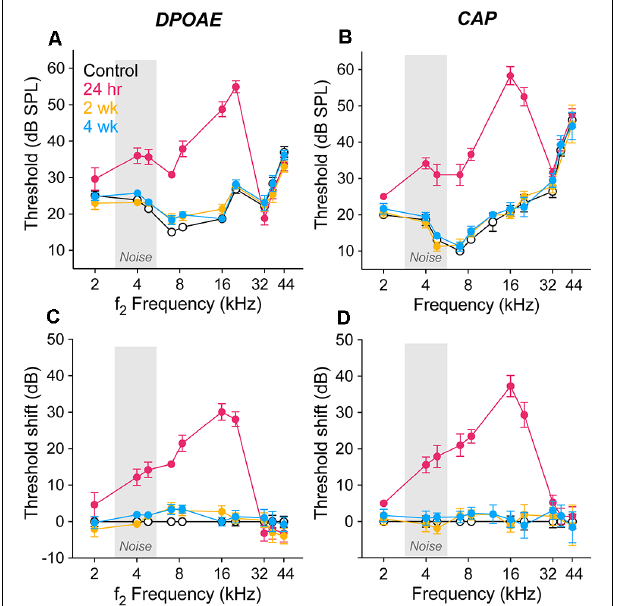
FIGURE 1 | Response thresholds and shifts from control. Thresholds of DPOAEs (A) and CAPs (B) are shown as response means ± SEM for unexposed controls (white/black) and groups of gerbils held 24 h (magenta), 2 wk (orange), and 4 wk (blue) after noise (2.8–5.6 kHz, 100 dB SPL, 2 h). Corresponding shifts from control values are shown in panels (C) and (D ). The exposure noise band is indicated in light gray. Group sizes were: control (14), 24 h (7), 2 wk (7), 4 wk (9). For some group means, error bars do not exceed symbol boundaries. The color scheme applies to all figures. ANOVA models were run at 8 and 16 kHz using hierarchical tests at each frequency in a predefined sequence. Control vs. exposed groups was significant for both DPOAE and N1-P1 at both 8 and 16 kHz ( p < 0.001 in all four comparisons). 24 h vs. 2 and 4 wk groups was significant by both measures and at both frequencies ( p < 0.001 in all four comparisons). DPOAE and CAP thresholds at 2 wk and 4 wk post-exposure were not different at either frequency ( p = 0.80 and p = 0.45 at 8 kHz and 16 kHz, respectively). For all threshold analyses, alpha =